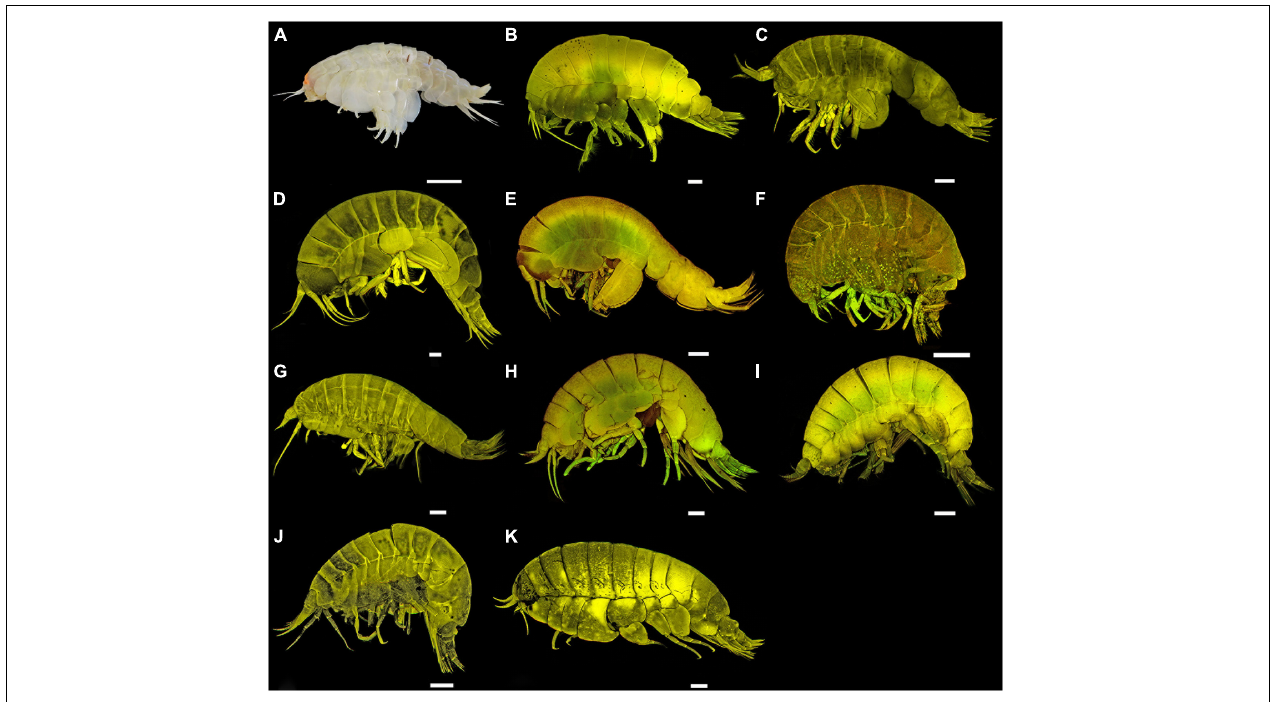
FIGURE 3 | Confocal images of all sampled taxa of Lysianassoidea (including one light microscopy image of a large species, A ). (A) Eurythenes magellanicus . (B) Eurythenes sp. DISCOLL PAP B. (C) Hirondellea brevicaudata . (D) Hirondellea guyoti . (E) Hirondellea sp. nov. DZMB_2021_0092. (F) Ambasiopsis sp. nov DZMB_2021_0093. (G) Haptocallisoma abyssi . (H) Paracallisoma aff. alberti . (I) Paracallisoma sp. nov. DZMB_2021_0094. (J) Pseudonesimus aff. abyssi . (K) Abyssorchomene distinctus . (A) : scale = 2 cm. (B,K) : scale = 1 mm. (C–J) : scale = 500 µ